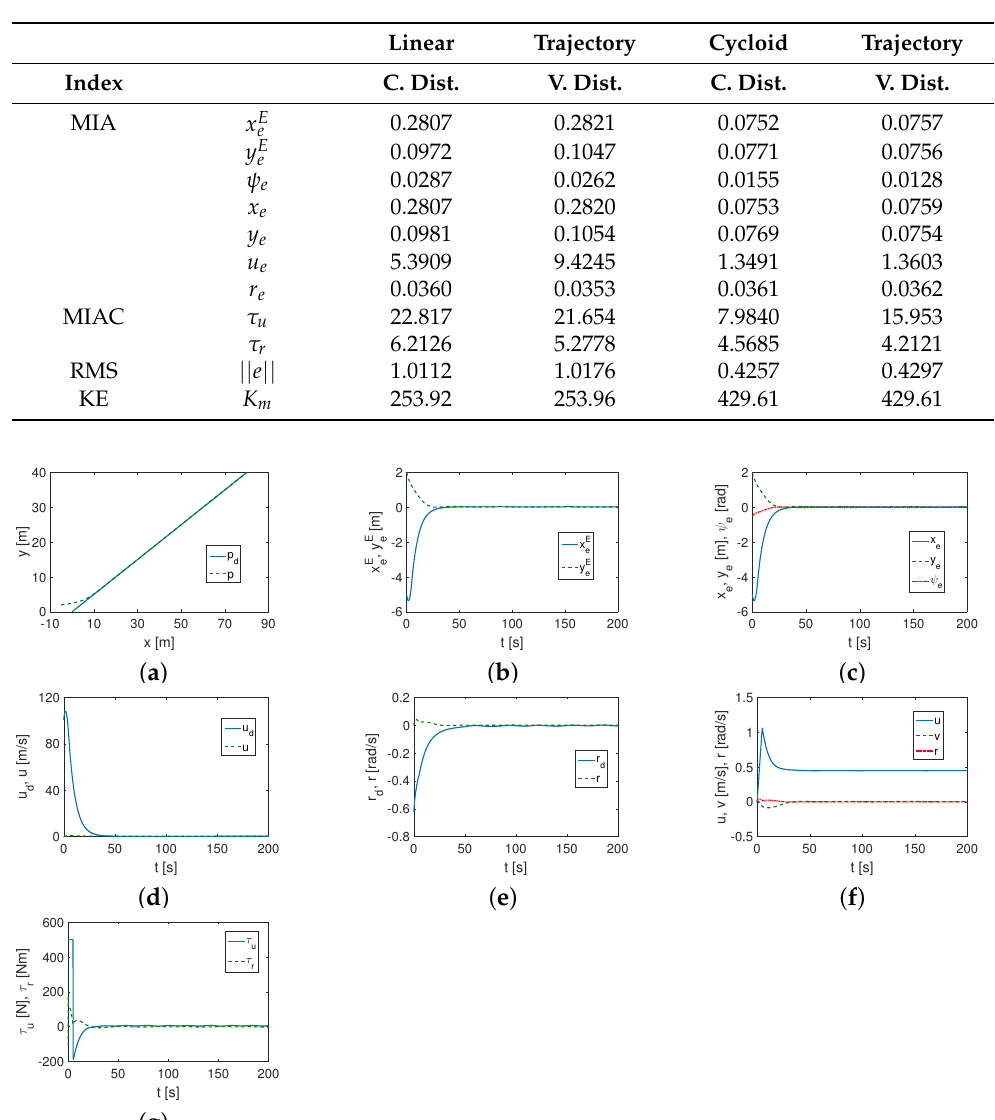
Table 2. Performance for SIRENE.